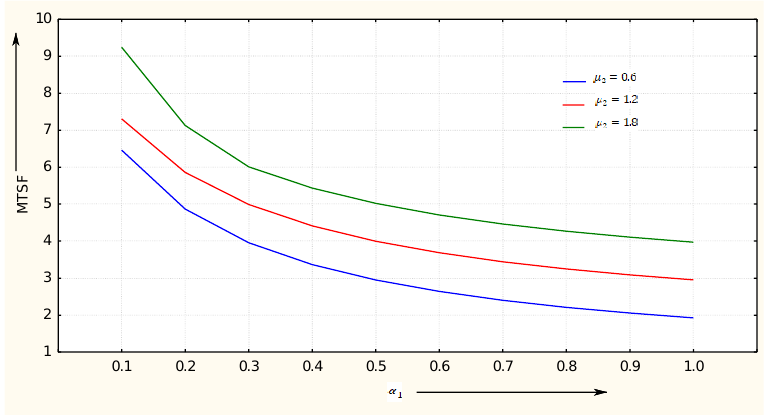
Figure 3. Behaviour of MTSF w.r.t 𝛼